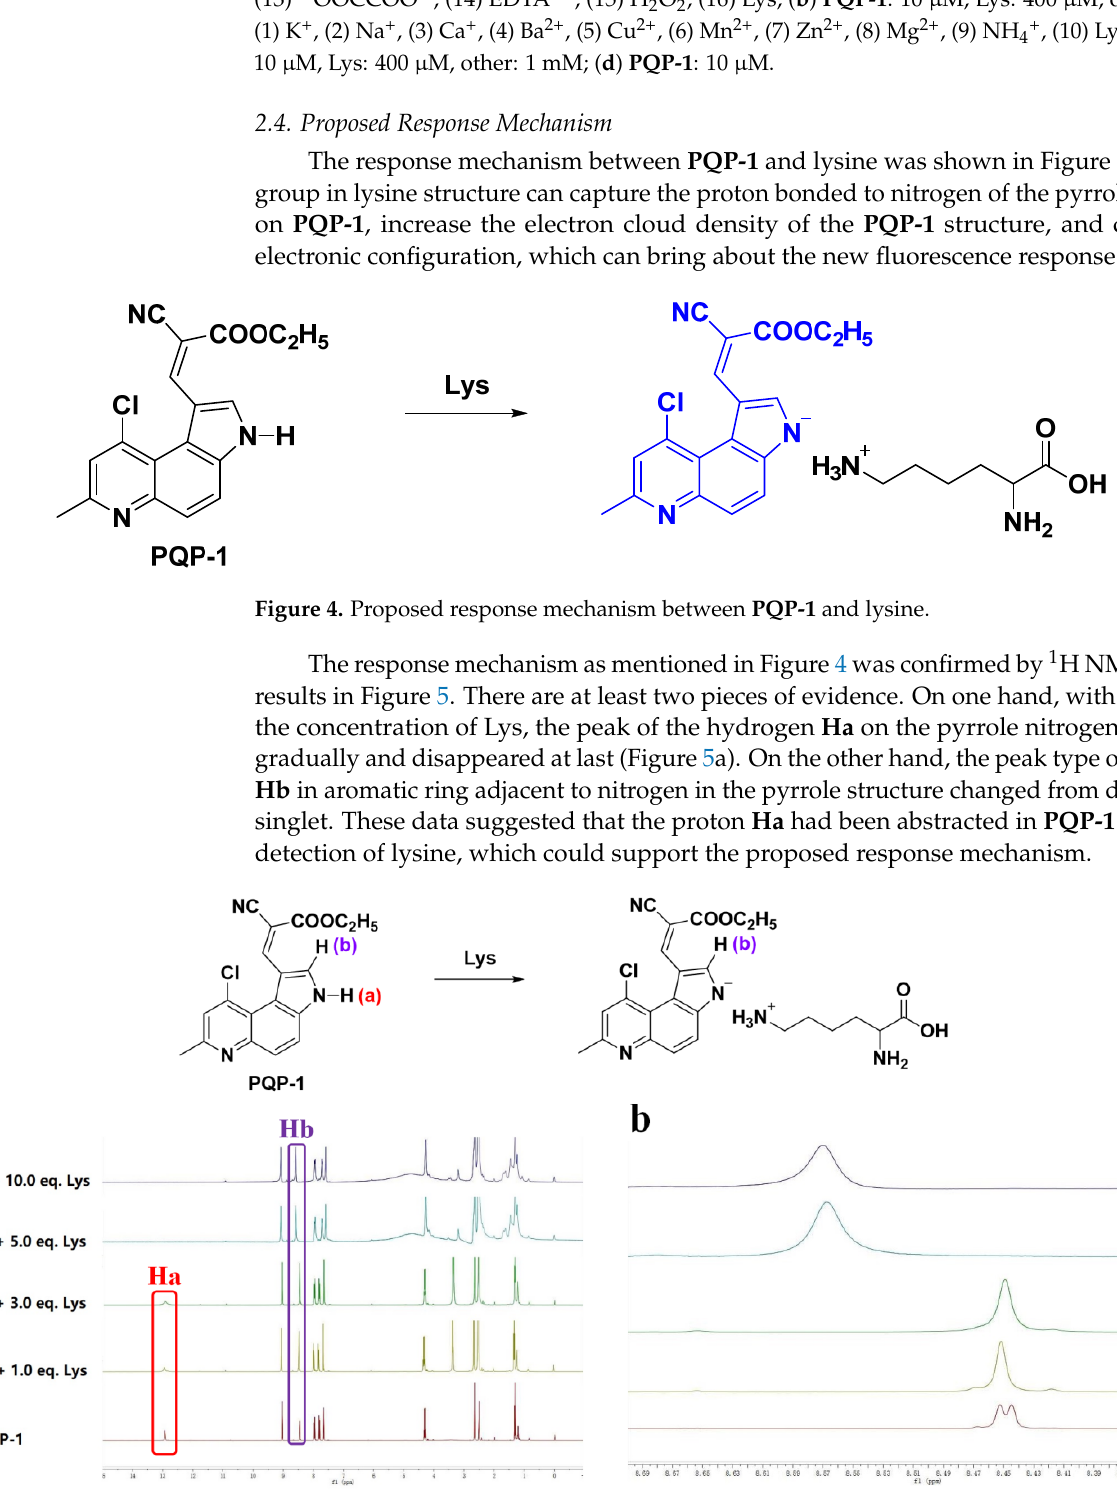
Figure 3. The selectivity of PQP ‐ 1 for Lys compared with various ions, Hcy, GSH, glucose (GLu), and other amino acids . ( a ) PQP ‐ 1 : 10 μ M, Lys: 400 μ M, other: 1 mM, (1) F − , (2) Cl − , (3) Br − , (4) I − , (5)